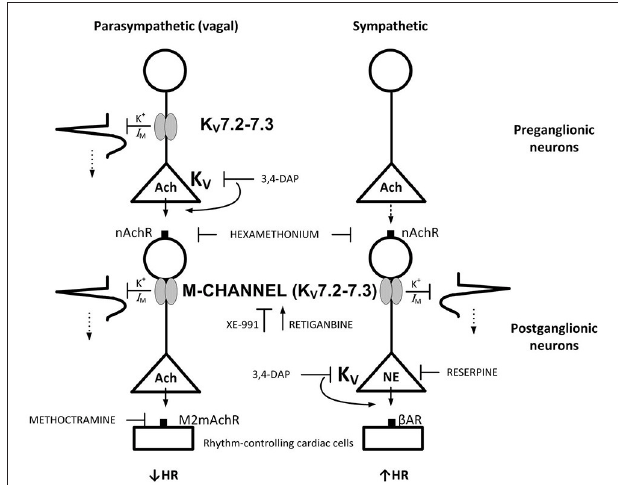
FIGURE 1 | M-currents are responsible for the vagal dysfunction and failing autonomic control of HR in SHR. By inhibiting Kv, 3,4-DAP will induce Ach release primarily from preganglionic parasympathetic neurons and norepinephrine from sympathetic nerve endings as indicated, and through that induce bradycardia followed by tachycardia.(Berg, 2015) M-currents (Kv7.2-7.3) hamper neuron excitability. In the parasympathetic branch, the M-channels may be located both in the preganglionic and postganglionic neurons, whereas a postganglionic localization seemed likely in the sympathetic branch. Drug names indicate site of main action. Arrows and blunted arrows indicate stimulatory and inhibitory actions, respectively.